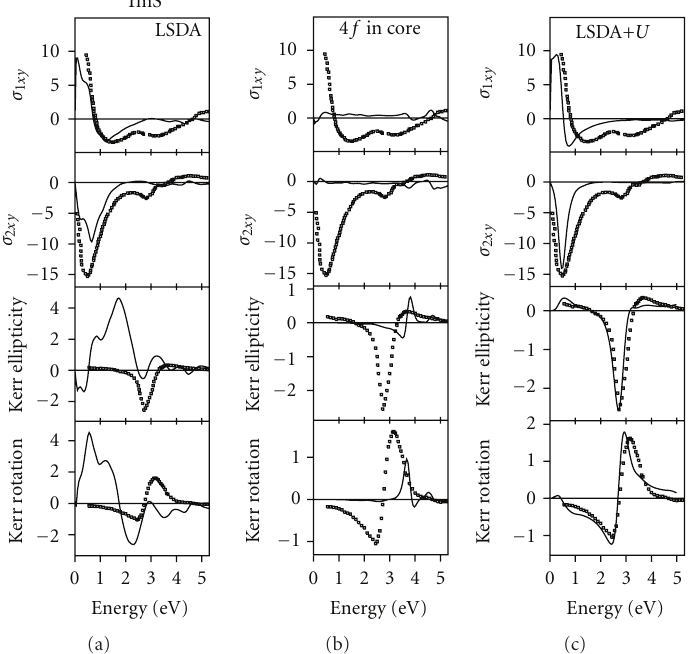
Figure 66: Calculated o ff -diagonal parts of the dielectric function ε xy (in 10 29 s − 2 ), Kerr rotation and Kerr ellipticity spectra (in degree) for TmS treating the 4 f states as a core electrons, LSDA and LSDA+ U approximations [384] compared with experimental data (circles)